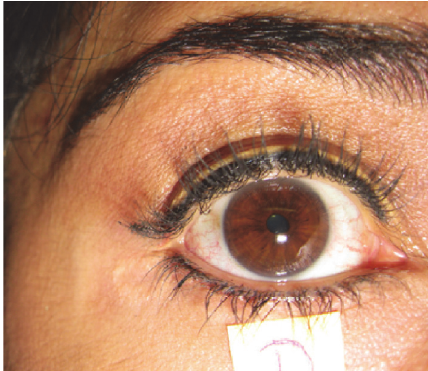
Figure 1: Right pupil with oval shape unresponsive to light stimula- tion delayed dilatation after accommodation; contracted briskly to accommodation and pilocarpine